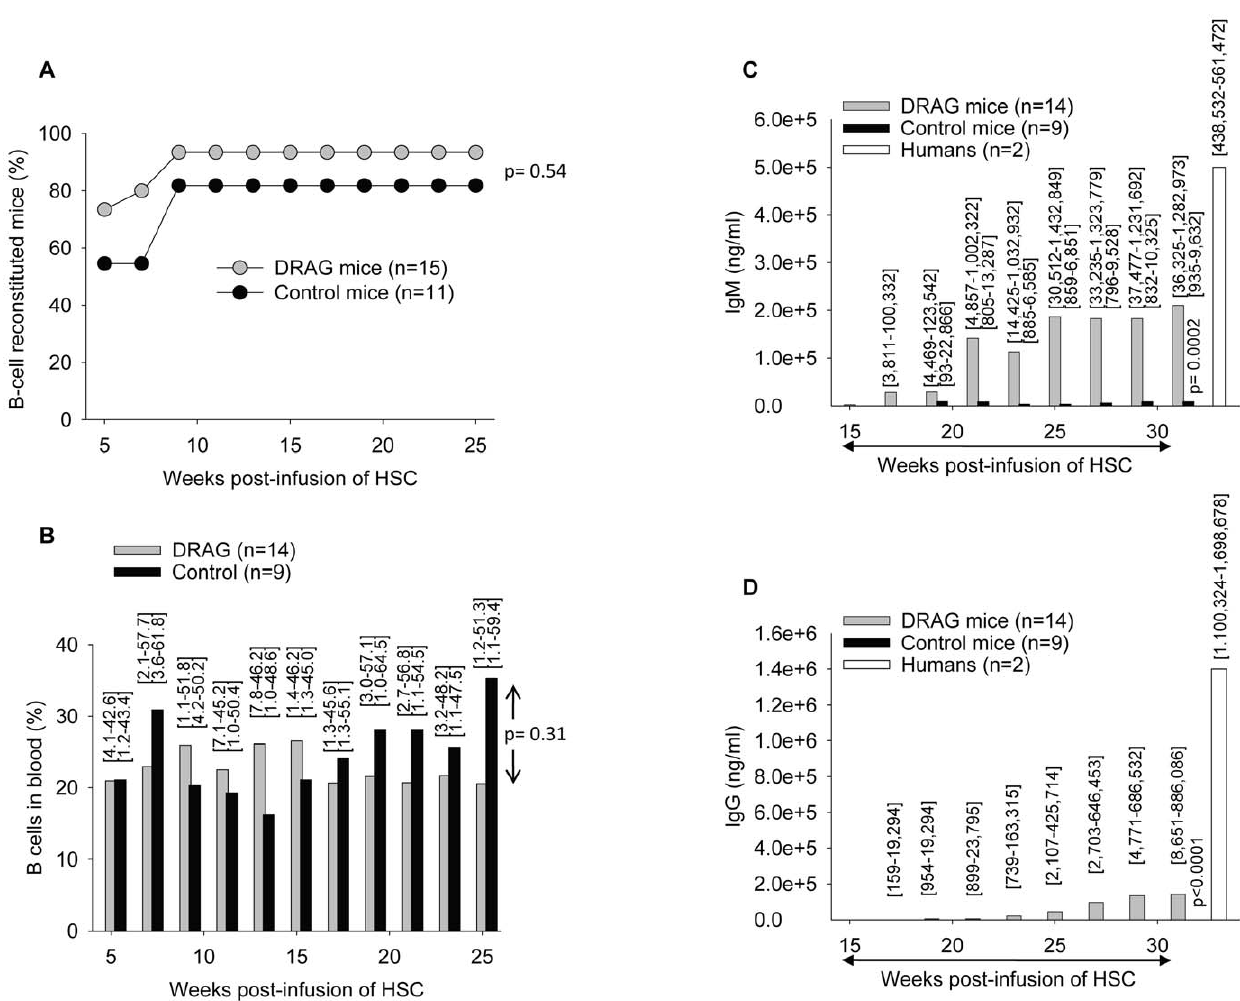
Figure 5. Kinetics of human B cell reconstitution in blood of DRAG and control mice. DRAG (n=15) and control (n=11) mice as in figure 1 were examined in peripheral blood by FACS using human CD19 Abs. The cut-off for positive human B cells was calculated as three times the standard deviation over the background of cells from naı¨ve (non-HSC infused) DRAG mice stained with CD19 antibodies ( . 0.18%). Panel A, percentage of human B cell reconstituted mice at various time points post-infusion of HSC. Fisher exact test indicated that the rate of human B-cell reconstitution in DRAG mice (14 out of 15) was similar to that of control mice (9 out 11) (p=0.54). Panel B, frequency of human B cells in blood of reconstituted DRAG (n=14) and control (n=9) mice (p=0.31, Mann-Whitney test). Panels C and D, plasma values of human IgM and IgG respectively in B-cell reconstituted DRAG (n=14) and control (n=9) mice at various time points post-infusion of HSC (p values 0.0002 and , 0.0001, Mann-Whitney test). Data represent mean values of mice analyzed individually. Ranges are indicated over the